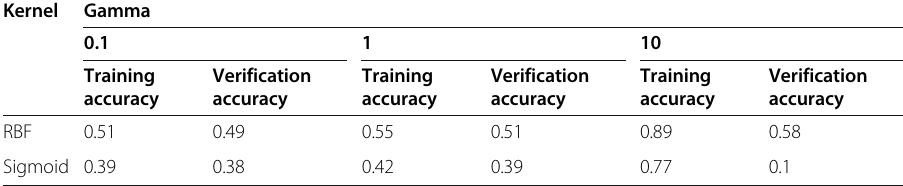
Table 6 Results using the second dataset Kernel